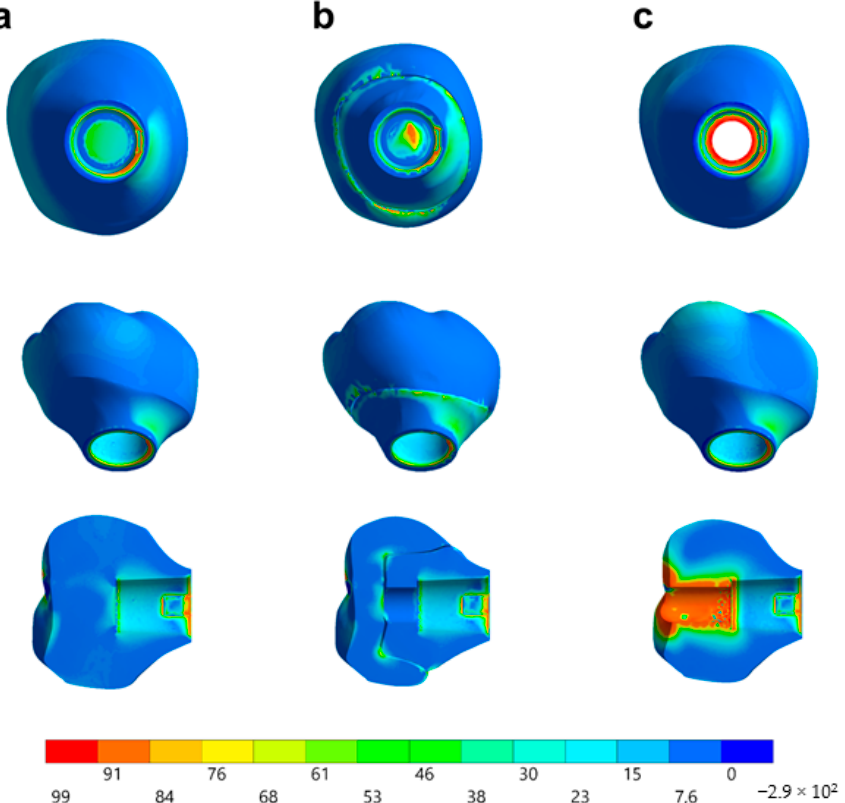
Figure 15. Stress distribution assessed by the maximum principal stress criterion according to the design of the restoration. ( a ) MC, ( b ) CME, and ( c ) MP.